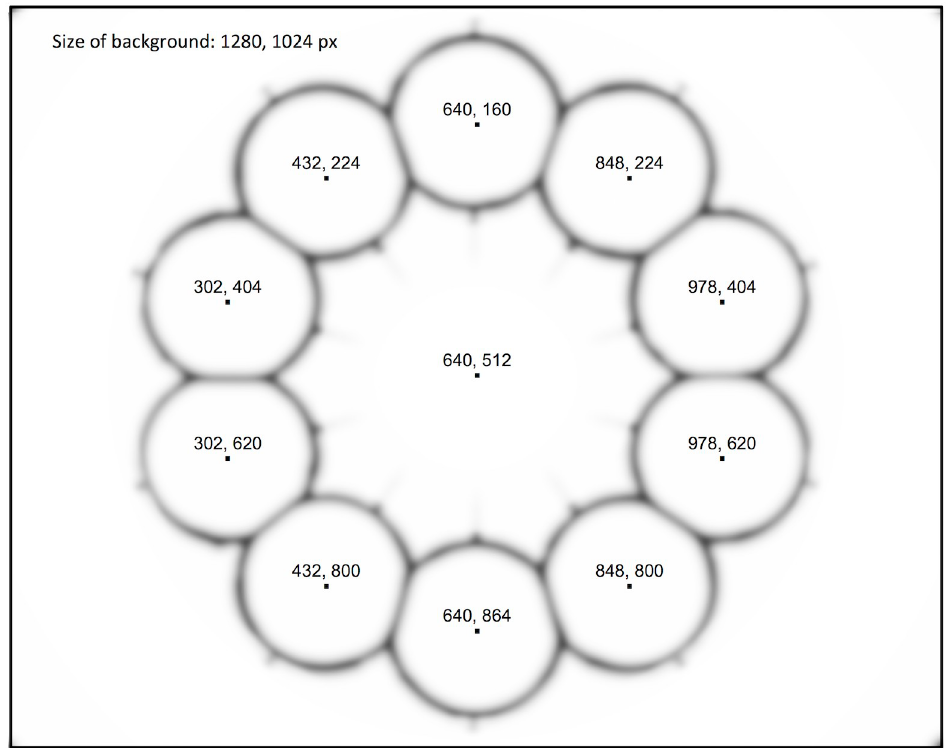
Fig 2. The arrangement of target locations and blurred contours. Central pixel coordinates of the ten possible target locations, in equal distance to the background center (first value: horizontal from top left, second value vertical). The contours around all of the possible target locations—arranged as circles in a ring—were blurred on each background image, and the target patch was included in one of the circles, respectively.